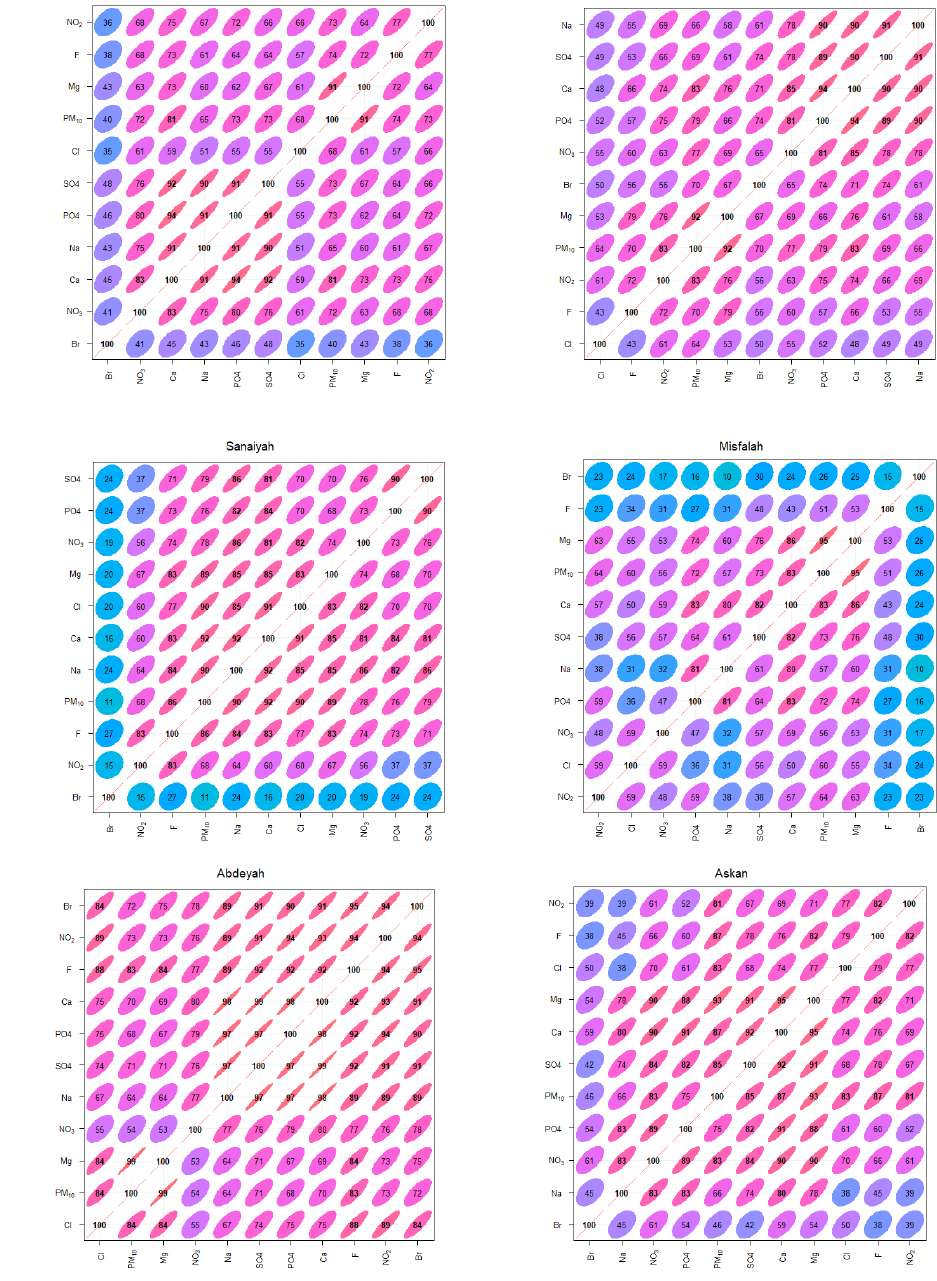
Figure 5. Correlation plots of different ions with each other and with PM 10 at each sampling site in Makkah. The top panel “all sites” shows correlation plots of the pooled data from all sites, while the other panels are named according to the name of the sites.